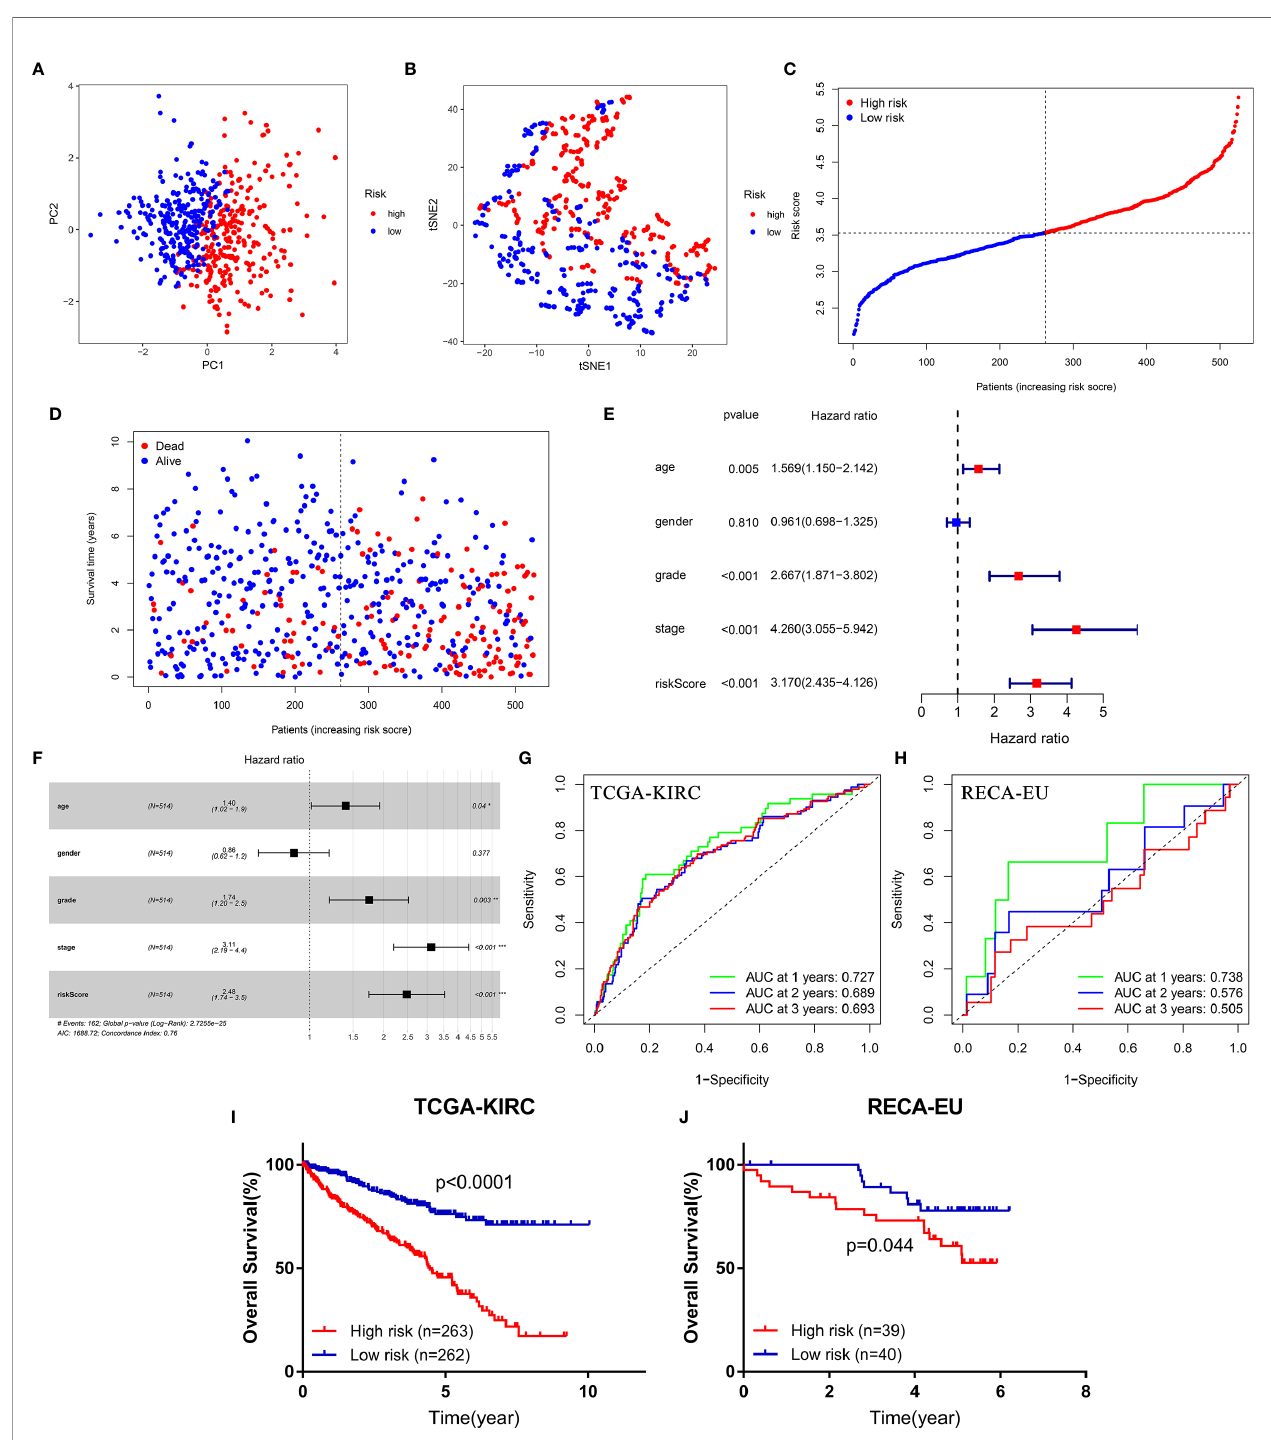
FIGURE 3 | The diagnostic and prognostic value of the four-gene signature (FeSig). (A, B) PCA and t-SNE analysis both veri fi ed that FeSig could signi fi cantly divide patients into different risk groups. (C) The distribution and median value of the risk scores in the TCGA cohort. (D) Patients with high-risk score had poor OS. (E, F) Univariate and multivariate Cox regression analyses indicated that risk score was an independent prognostic factor (HR = 2.48, p < 0.001). (G, H) The risk score had good diagnostic value. (I, J) High-risk group predicted poor OS both in TCGA and ICGC cohort. FeSig, ferroptosis-related gene signature; PCA, principal component analysis; t-SNE, t-distributed stochastic neighbor embedding; TCGA, The Cancer Genome Atlas; OS, overall survival; ICGC, International Cancer Genome